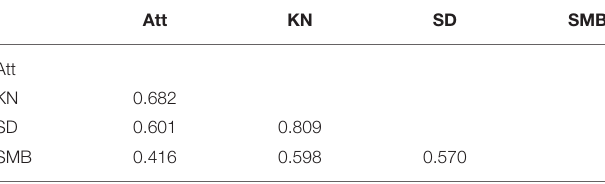
TABLE 6 | Heterotrait-monotrait (HTMT) ratio.